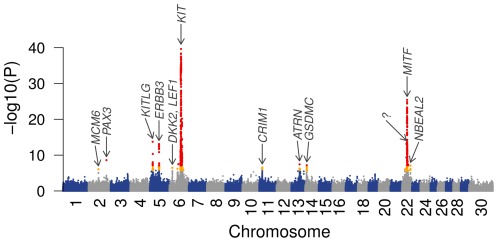
Manhattan plot of association of 658,385 SNPs with the proportion of daughters with ambilateral circumocular pigmentation in 3579 bulls of the Fleckvieh breed.The chromosomes are separated with alternating colours. Orange and red dots indicate chromosome-wide and genome-wide (P<7.59×10−8) significantly associated SNPs, respectively. The vertical axis is truncated for P values below -log10(10–41). Twelve identified QTL regions are indicated with arrows and gene identifiers.